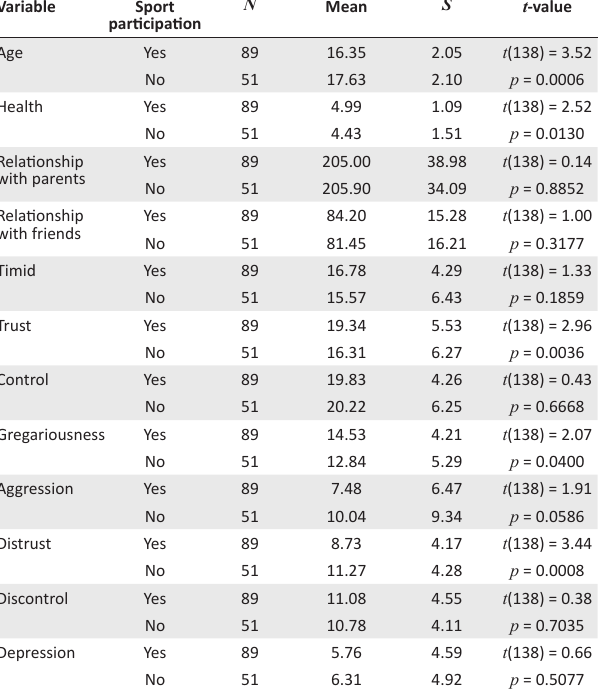
TABLE 2: Differences with regard to age, health, social relationships and emotions of learners who participate in sport and those who do not participate. Variable Sport participation